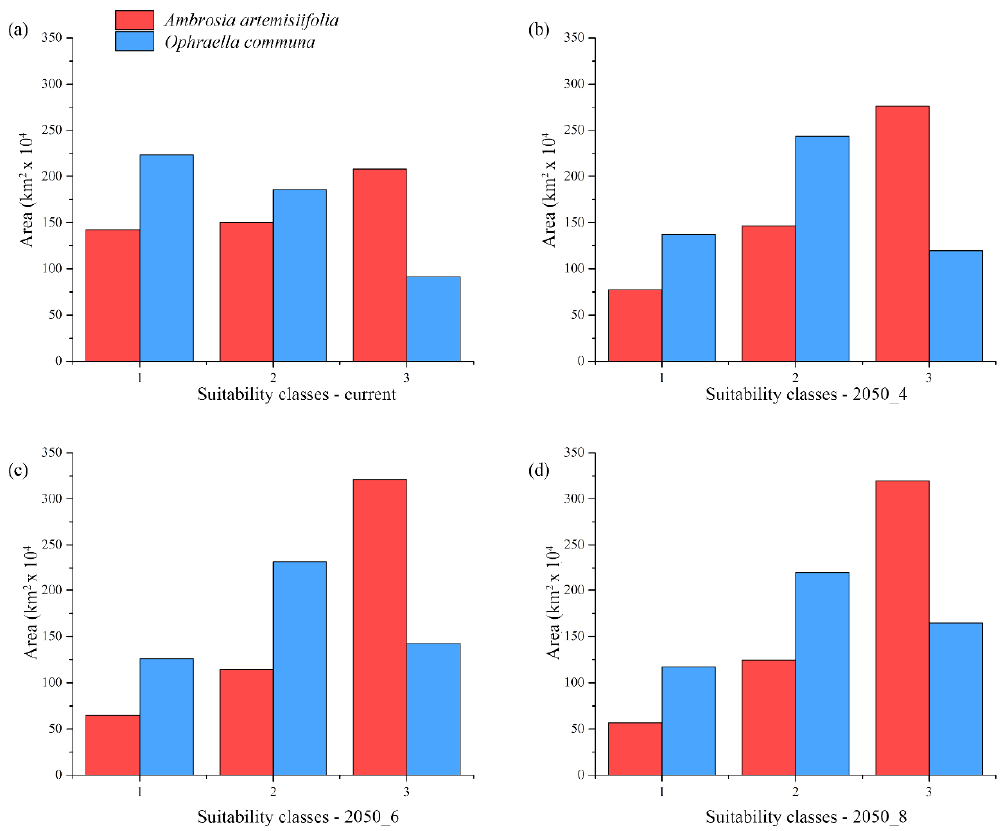
Figure 2. Suitable areas predicted for Ambrosia artemisiifolia and Ophraella communa for current and future climate scenarios. Predicted low (1), medium (2), and high (3) suitable areas for current ( a ), 2050—RCP 4.5 ( b ), 2050—RCP 6.0 ( c ), and 2050—RCP 8.5 ( d ) scenarios for Ambrosia artemisiifolia (red) and Ophraella communa (blue).